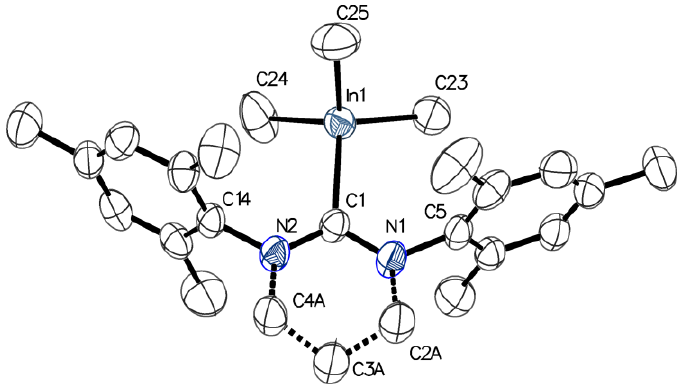
Figure 2. Molecular structure of 2 with thermal ellipsoids at 50% probability level. Selected bond lengths [Å] and angles [ ◦ ]: In(1)–C(1) 2.367(2), In(1)–C(25) 2.185(3), In(1)–C(24) 2.179(3), In(1)–C(23) 2.198(3),